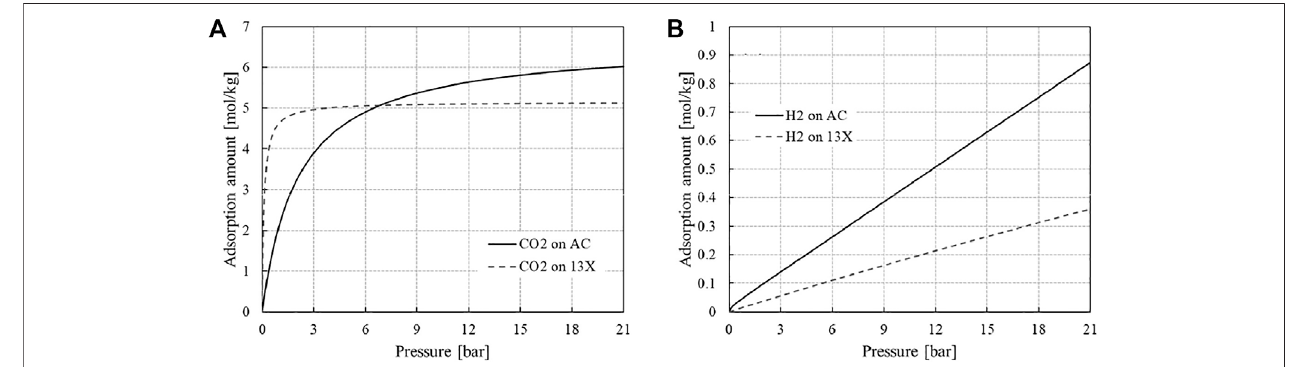
FIGURE 4 | Equilibrium adsorption isotherms of (A) CO 2 and (B) H 2 on zeolite 13X and activated carbon at 308